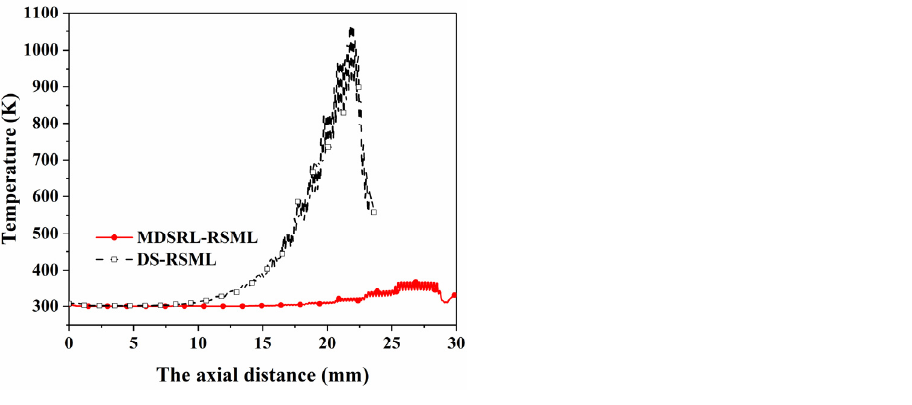
Figure 14. Temperature distribution along the axis of the DS-RSML SWS and MDSRL-RSML SWS.